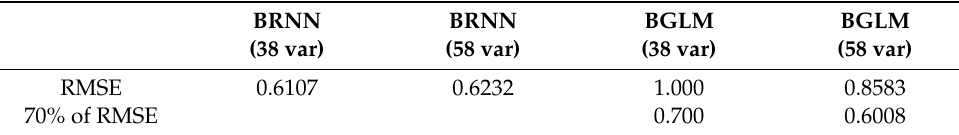
Table 5. RMSE comparison: 70% of compared